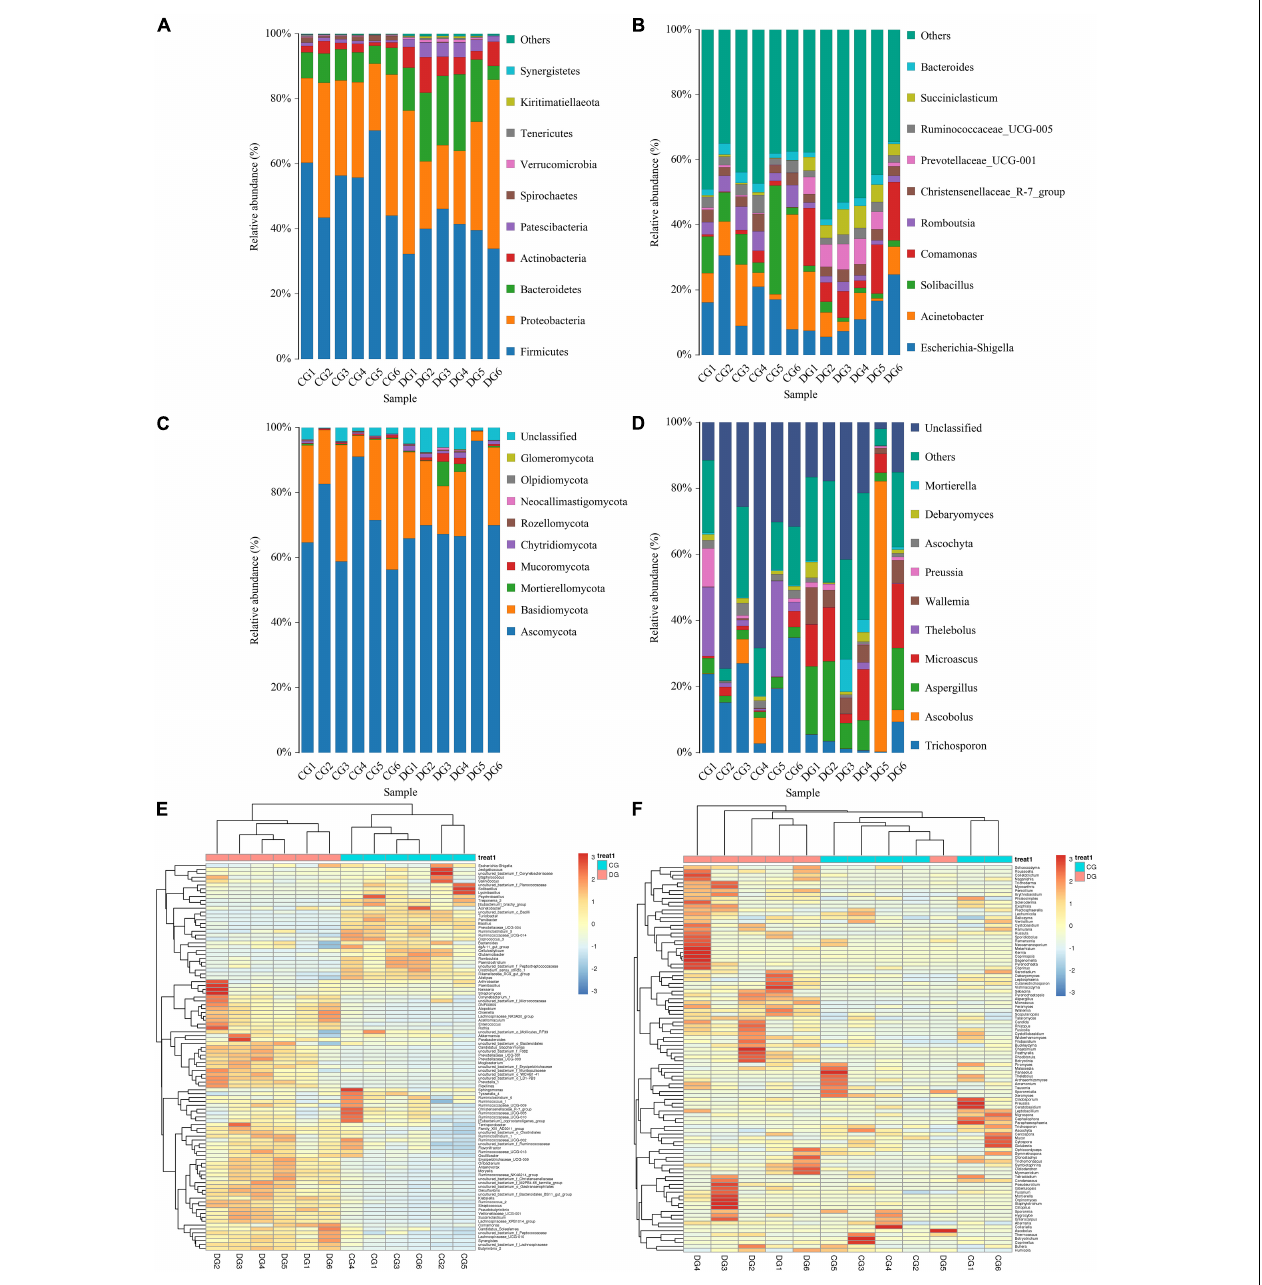
FIGURE 3 | The composition and relative abundance of the gut microbial community at the phylum and genus levels. (A,B) The gut bacterial relative abundance and composition of healthy and diarrheic giraffes at the phylum and genus levels. (C,D) The gut fungal relative abundance and composition of healthy and diarrheic giraffes at the phylum and genus levels. (E,F) Heatmap of the 50 most abundant gut bacterial and fungal genera in healthy and diarrheic